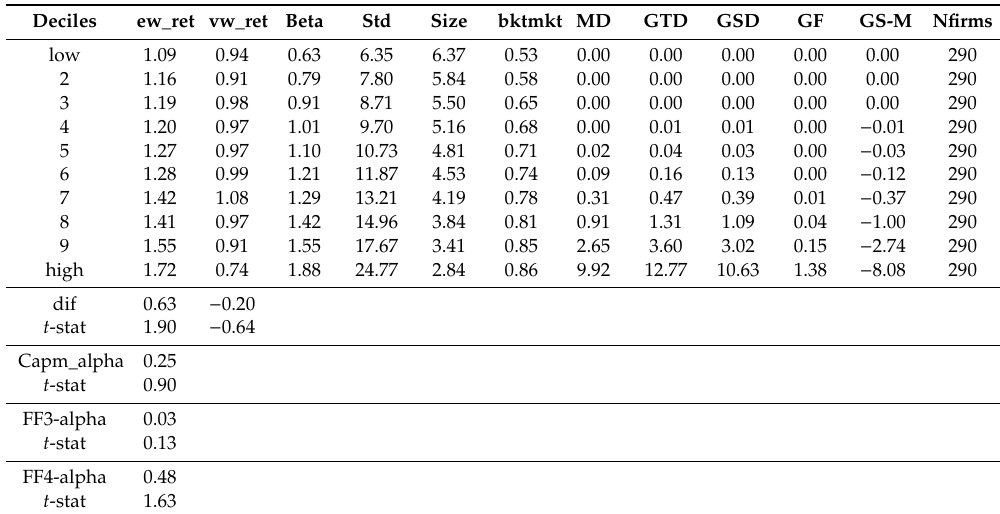
Table 3. Average returns from ddecile portfolios sorted by Geske’s total default probability. From the data for July 1963 to December 2013, at the end of each month, we used the most recently calculated Geske’s total default probability for each firm to sort all stocks into deciles. We then calculated the equally weighted and value-weighted returns over the next month. The returns are the average monthly returns over the sample period. Portfolio 1 is the portfolio with the lowest default risk and Portfolio 10 is the portfolio with the highest default risk. High-Low is the di ff erence between the high and low default risk portfolios. t -values are calculated from Newey-West standard errors. Alphas are calculated using the CAPM, the three-factor Fama-French, and the four-factor model (Fama-French three-factor plus